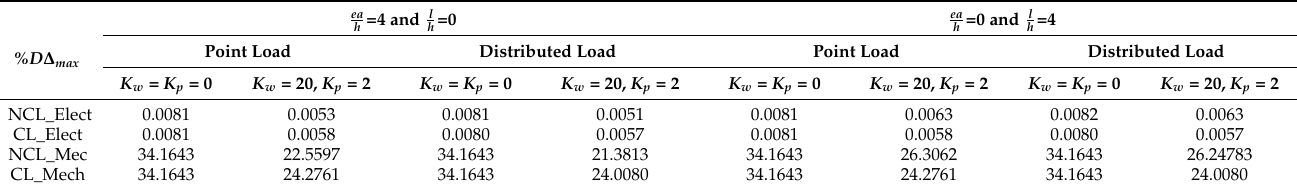
Table 6. The relative percentage difference in the transverse deflection ( % D ∆ max ) the number of hole rows N for electromechanical and mechanical nonclassical and classical behaviors for different values of the nondimensional elastic foundation and nonclassical parameters under point and uniformly distributed loads at perforation filling ratio, α = 0.5, and beam aspect ratio L / h = 20, e 311 = − 4.1 C/m 2 , µ 3111 = 5 × 10 − 8 C/m, a 33 = 7.124 × 10 − 9 C/m 2 K, and N = 1 to 10.